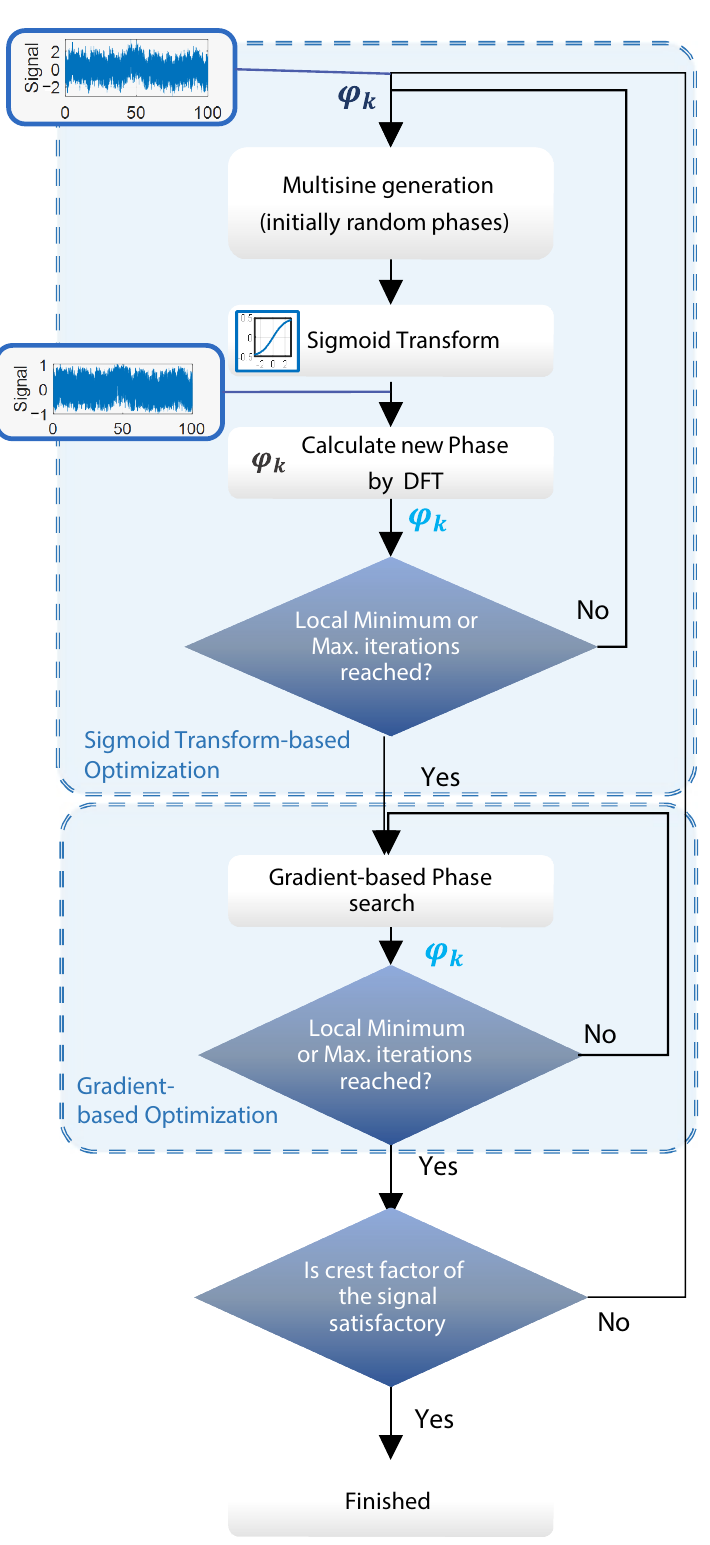
Figure 6. Algorithm for signal transformation towards a multi-frequency signal with lower crest